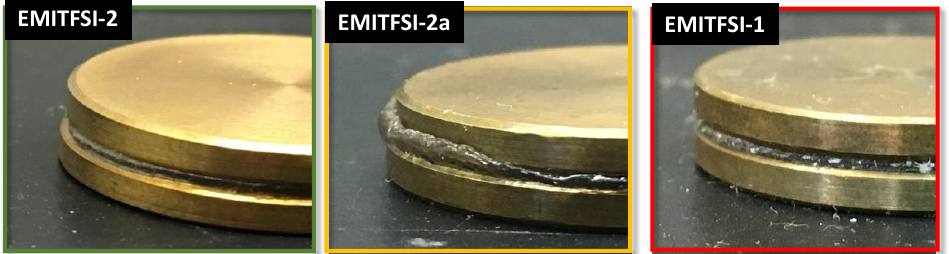
Figure 3. The electrolytes sandwiched between gold electrodes after enduring 20 min at 80 °C and 20 min at 90 °C.